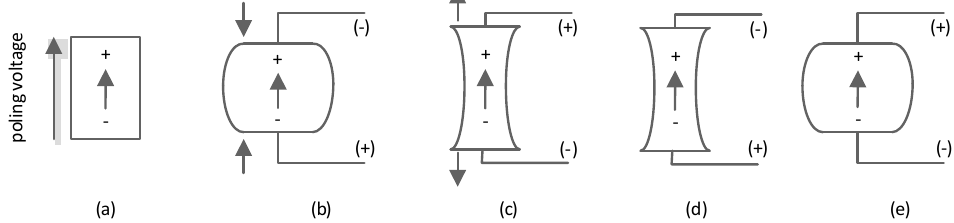
Figure 11. Reaction of a piezoelectric component to applied force or voltage [16]: poling direction ( a ), compression applied to the material in the poling direction generates voltage of the same polarity as the poling voltage ( b ); tension applied to the material in the poling direction generates voltage of the opposite polarity to the poling voltage ( c ); voltage of the same polarity as the poling voltage causes the material extension in the direction of the poling voltage ( d ); voltage of the opposite polarity as the poling voltage causes the material contraction in the direction of the poling voltage ( e ).